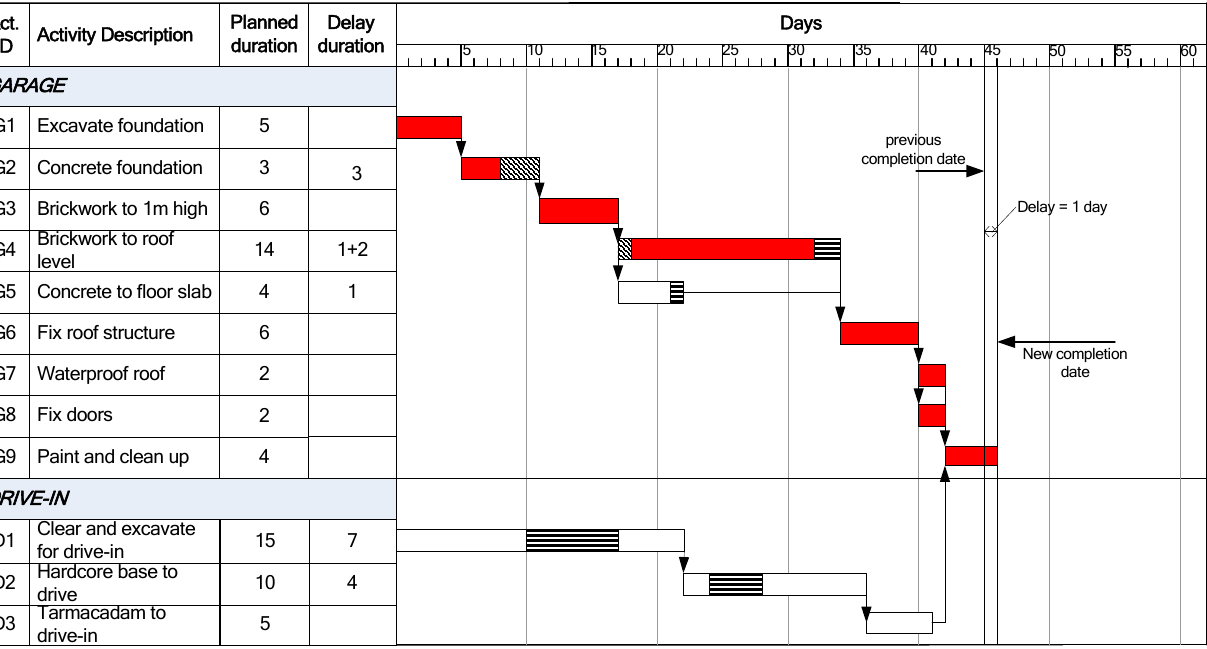
Figure 10. Impact of sixth